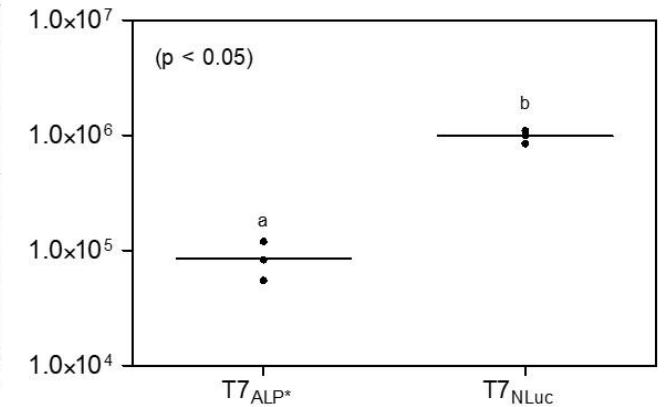
Figure 3. Reporter protein expressed following phage infection of E. coli BL21 cells. Different letters indicate statistically significant differences ( p < 0.05) in protein expression (n = 3).